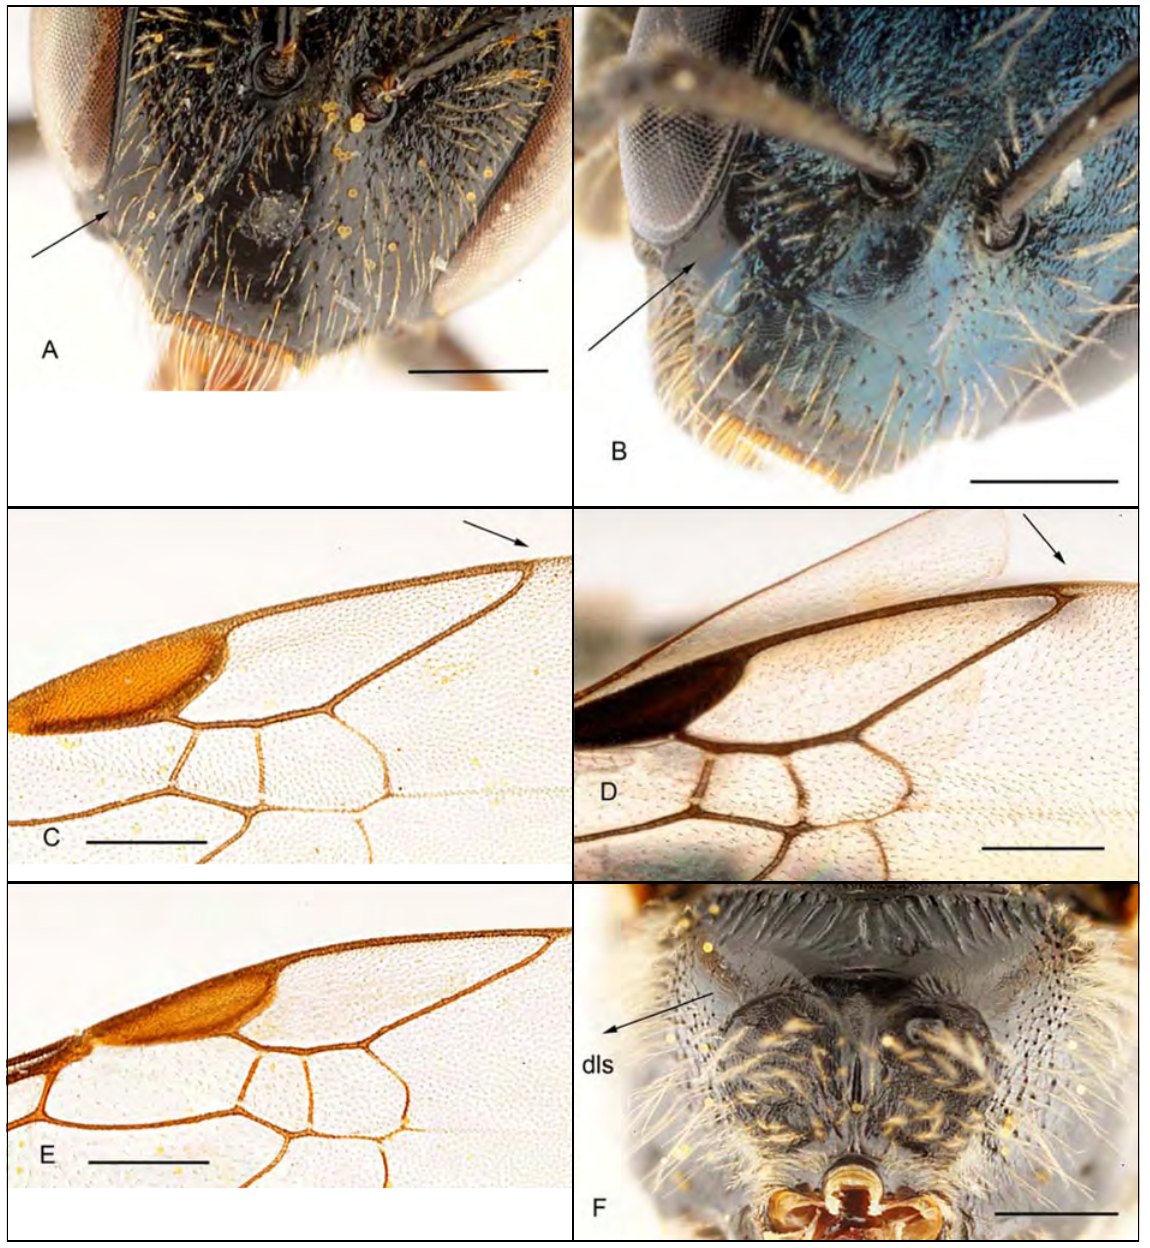
Fig. 1. — Lasioglossum ( Capalictus ) mosselinum (Cockerell, 1945) . A . Head showing lower paraocular area. C, E . Wing venation showing apex of marginal cell and weak veins of submarginal cells. C. ♀. E. ♂. F . ♀, propodeum and metapostnotum (dls = dorso- lateral slopes). — Lasioglossum ( Afrodia- lictus ) sp. B . Head showing lower paraocular area. — Lasioglossum ( Sellalictus ) sp. D . ♀, wing venation showing apex of marginal cell and weak veins of submarginal cells. Scale line = 0,5